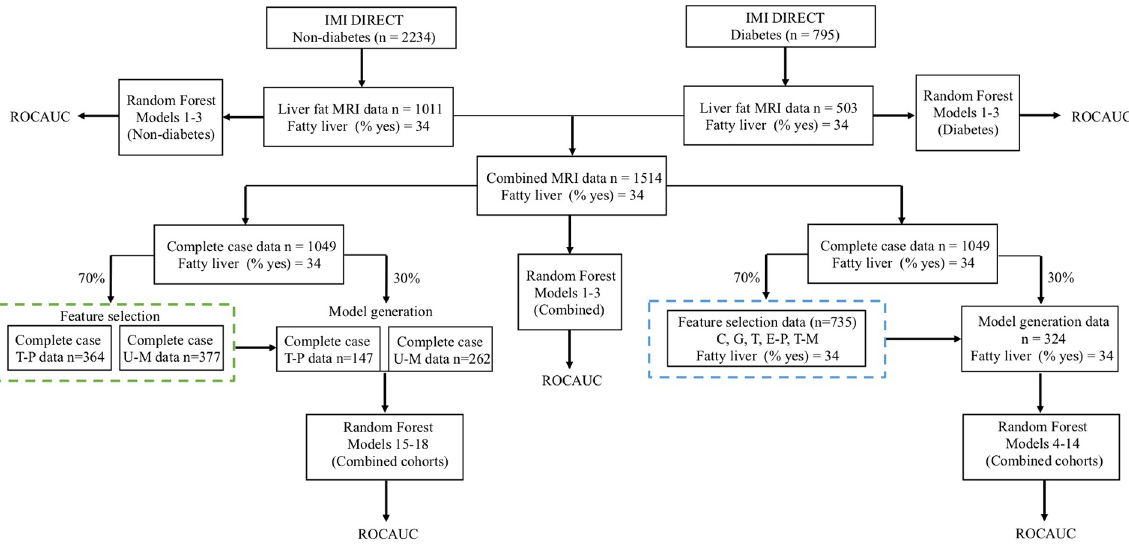
Fig 2. Overview of the different stages involved in data processing and model training. Data sources: clinical (C), genetic (G), transcriptomic (T), exploratory proteomic (E-P), targeted proteomic (T-P), targeted metabolomic (T-M), and untargeted metabolomic (U-M). The green and blue dashed boxes illustrate the feature selection step, the details of which can be found in S5 Fig. ROCAUC, receiver operating characteristic area under the curve.